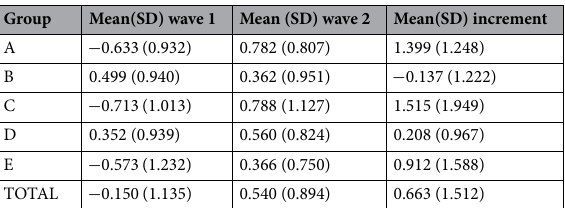
Table 2. Mean and standard deviation (SD) values for the µ parameter in December, May, and the increment in the µ value between December 2018 and May